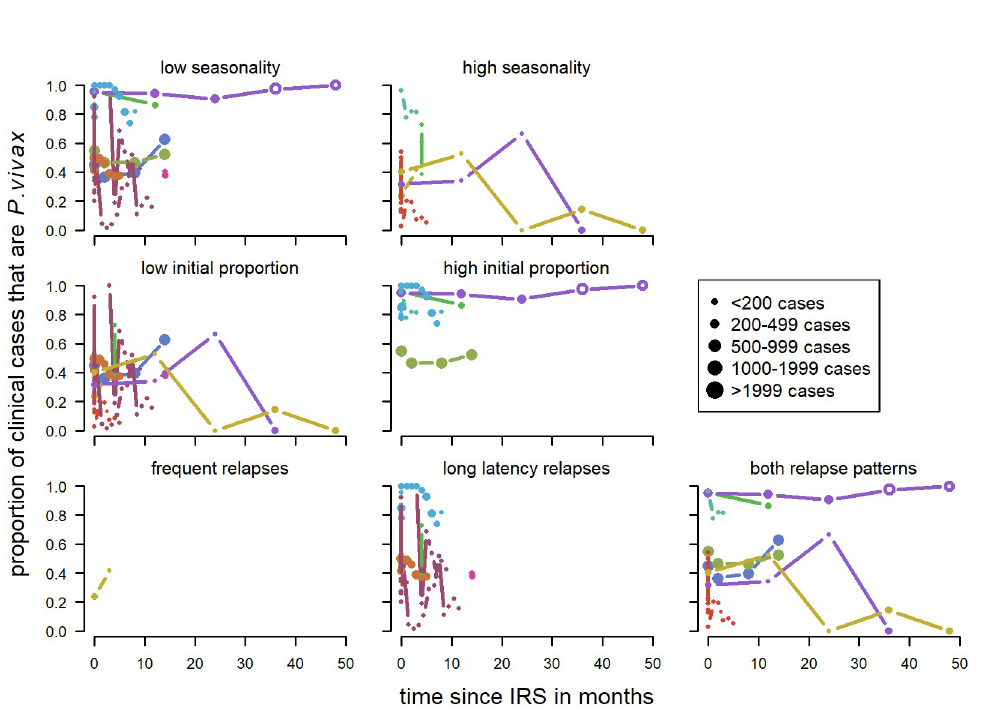
Fig 17. Spaghetti plots splitting the series of time-points of the proportion of cases with P. vivax infection by seasonality, initial proportion of P. vivax and relapse pattern after IRS. Dot size depending on number of infections.